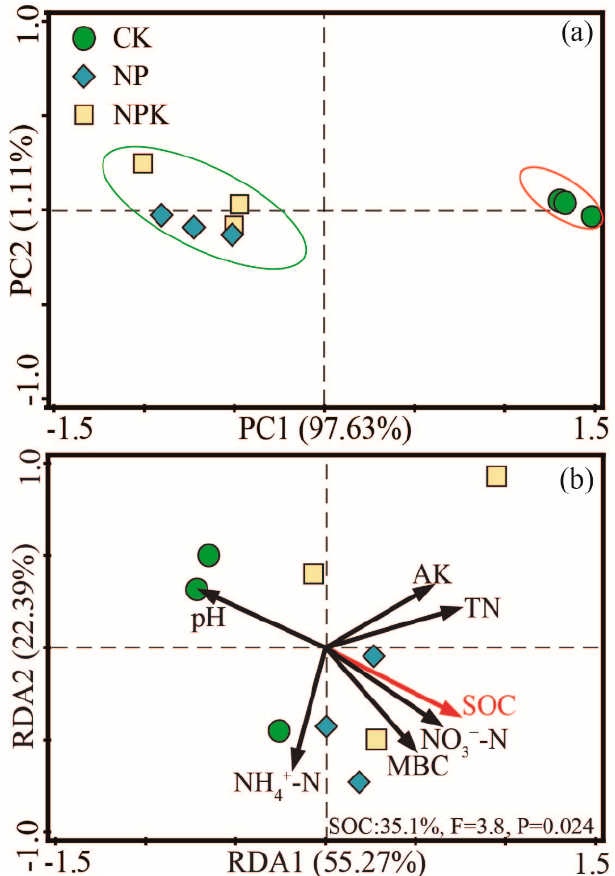
Figure 5. Principal components analysis (PCA) of microbial communities in soils from different long-term fertilizer treatments (CK, no fertilizer; NP, nitrogen and phosphorous fertilizer; NPK, nitrogen, phosphorus, and potassium fertilizer) ( a ). The circled symbols indicate significant groupings. Redundancy analysis (RDA) of the correlations between soil parameters and microbial community components ( b ). The red arrow indicates that SOC had a strong and significant effect on enzymatic activities ( p < 0.05), explaining 35.1% of the variability. TN: total N; AK: available K; SOC: soil organic carbon; MBC: microbial biomass C.